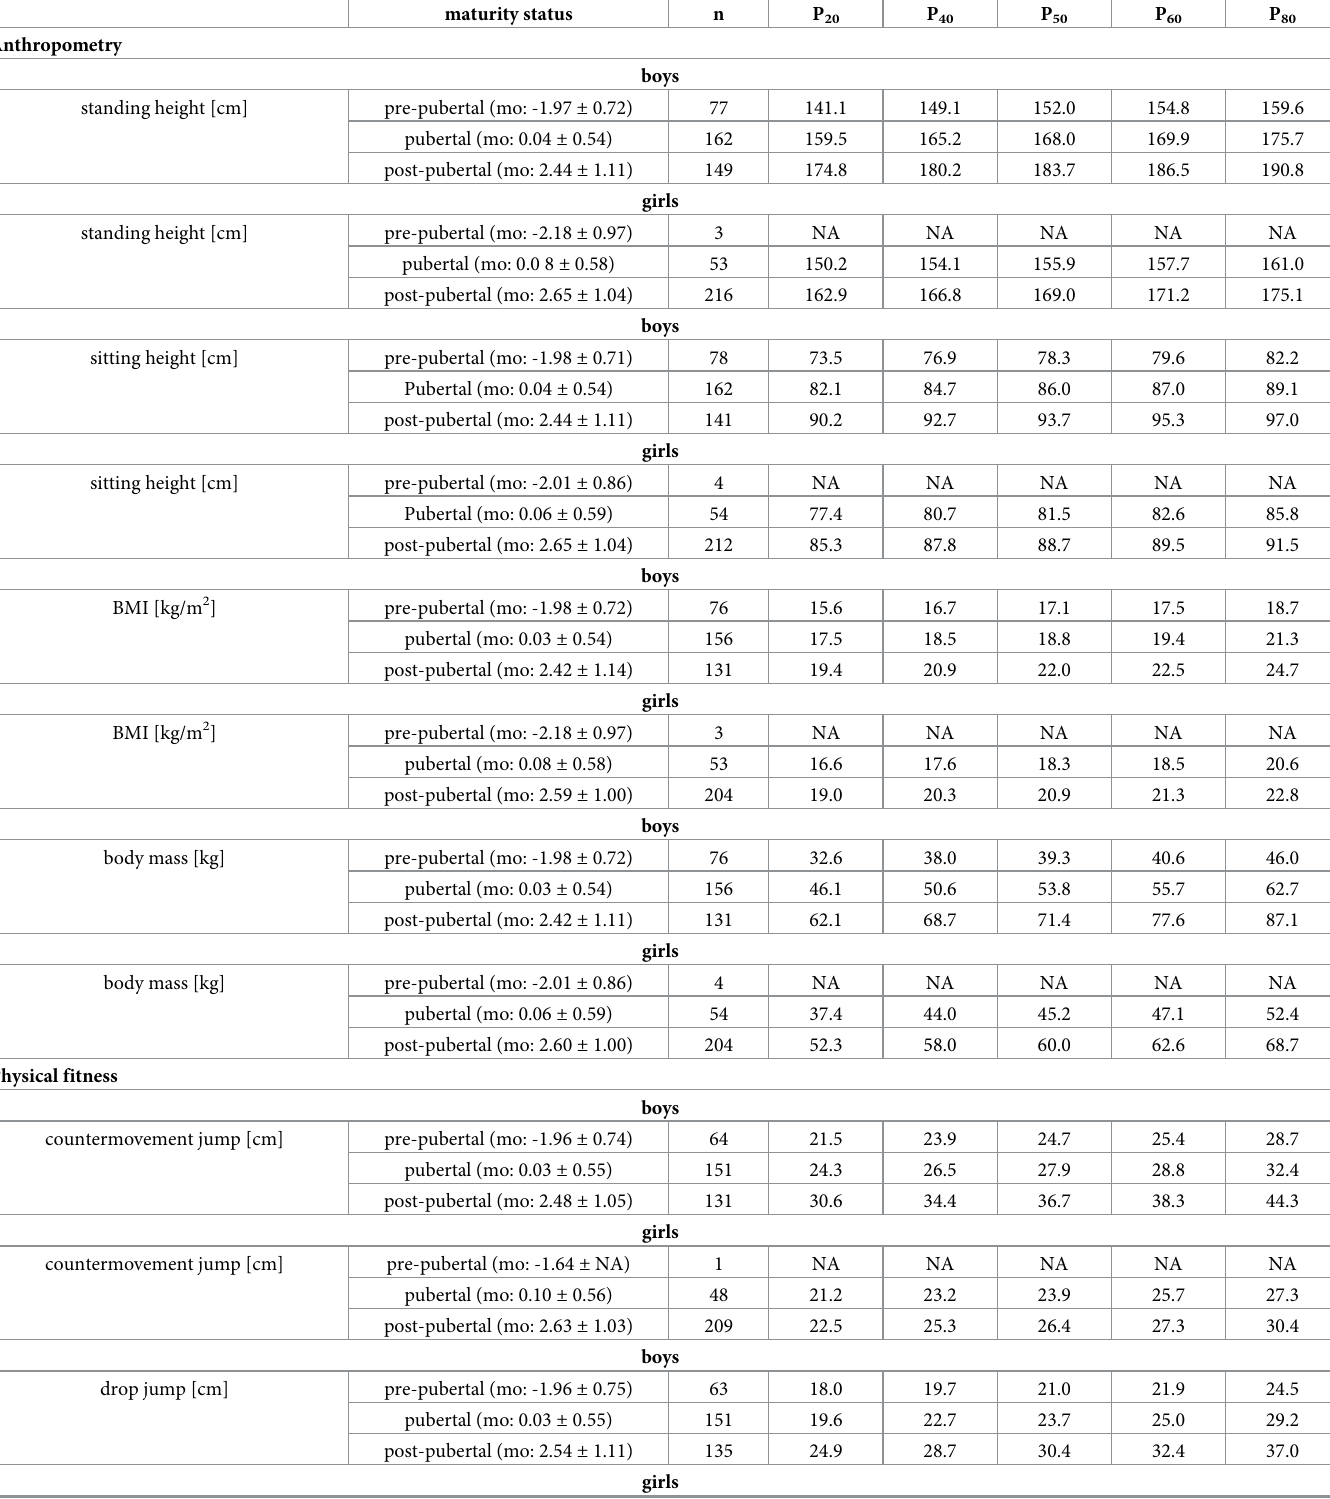
Table 4. Sex- and maturity-specific anthropometric and physical fitness percentiles of German elite young